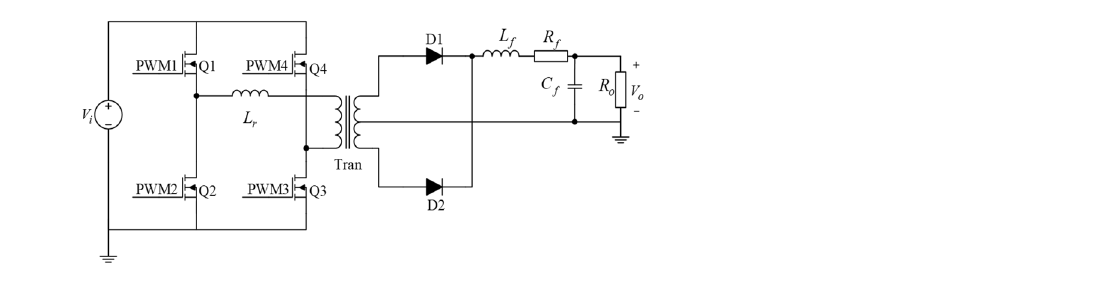
Figure 2. PSFB ZVS DC–DC